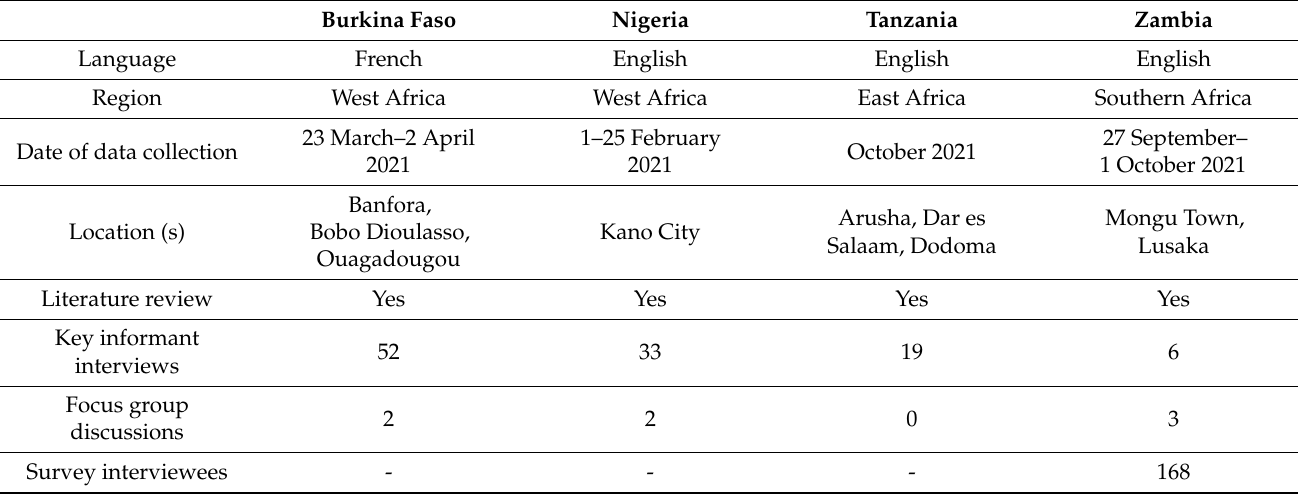
Table 2. Methodology of the four